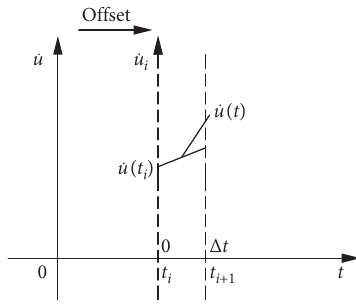
Figure 4: Velocity variation in time step.